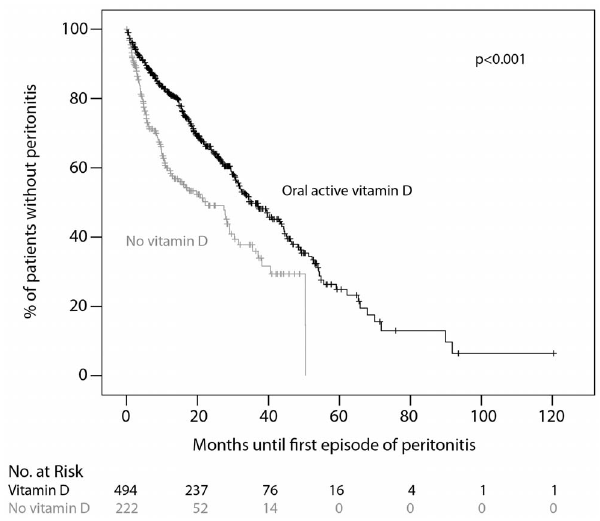
Figure 1. Kaplan-Meier analysis for time to first episode of peritonitis. Patients treated with oral active vitamin D at start of PD (black, n=494) were compared with untreated patients (grey, n=222). Data on vitamin D treatment were available for n=716 patients.